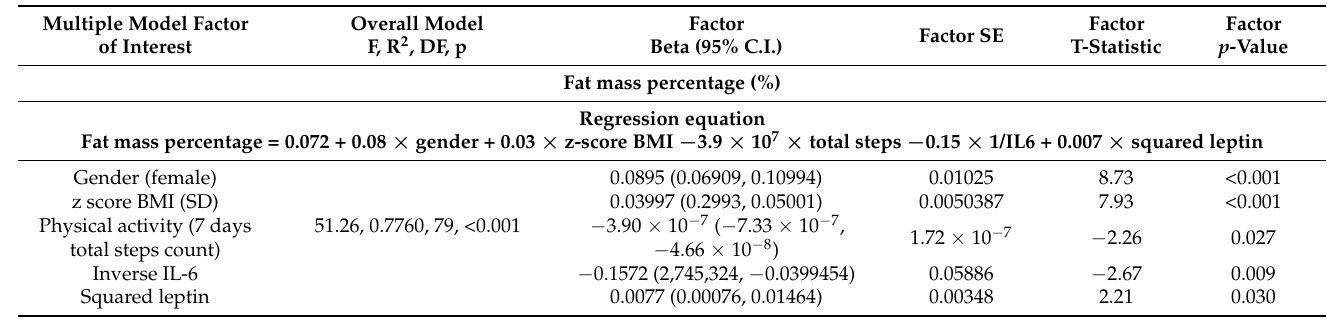
Table 7. Multiple regression models of fat mass percentage, after applying the forward stepwise method for variable insertion and evaluation with demographic and anthropometric data.